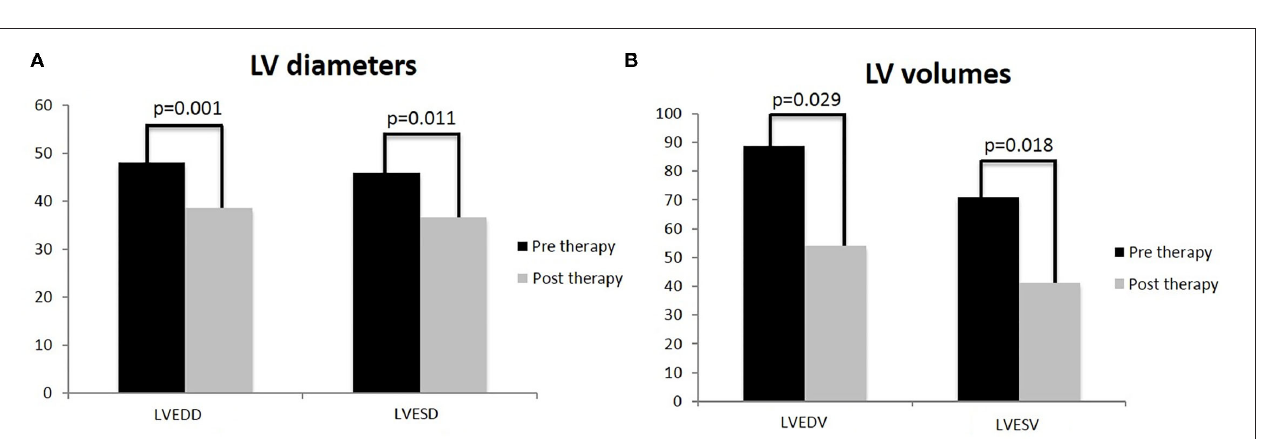
FIGURE 3 | T-test analysis on left ventricle diameters and volumes in children treated with carvedilol at baseline and at achievement of maximum dose. Left ventricular end-diastolic diameter (LVEDD) and left ventricular end-systolic diameter (LVESD) (A) ; left ventricle volumes: left ventricular end-diastolic volume (LVEDV) and left ventricular end-systolic volume (LVESV) (B) . Values are represented by mean.